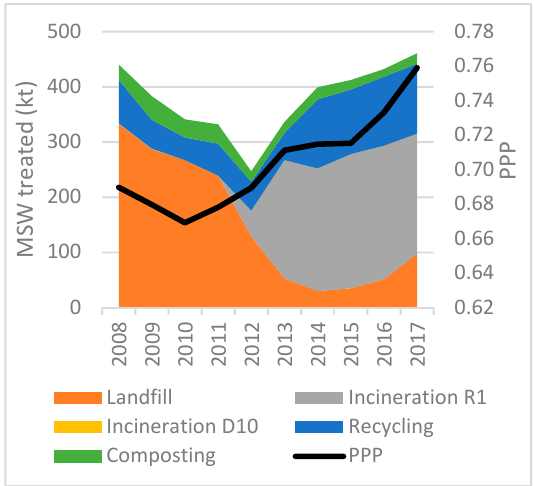
Figure 12. Waste treatment methods and PPP in Estonia 2008–2017 (EUROSTAT 2019b, 2019c).